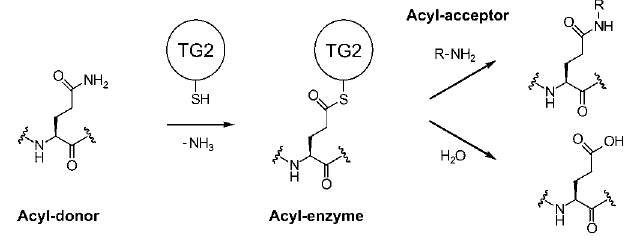
Figure 1. Reactions Catalyzed by